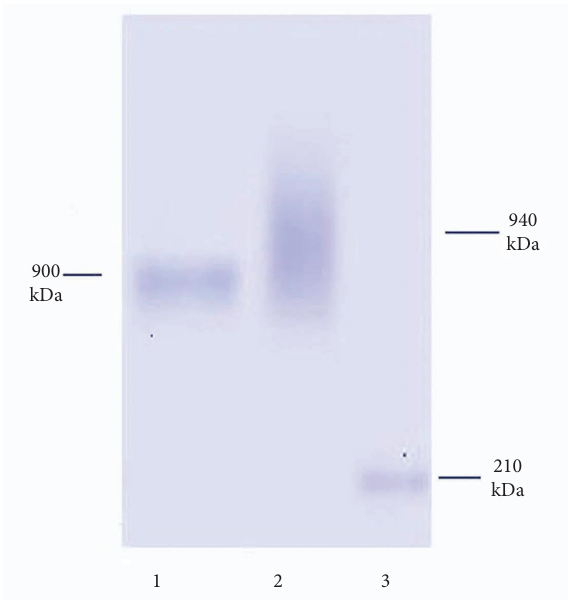
Figure 1: SDS-PAGE (native) under non reduced condition